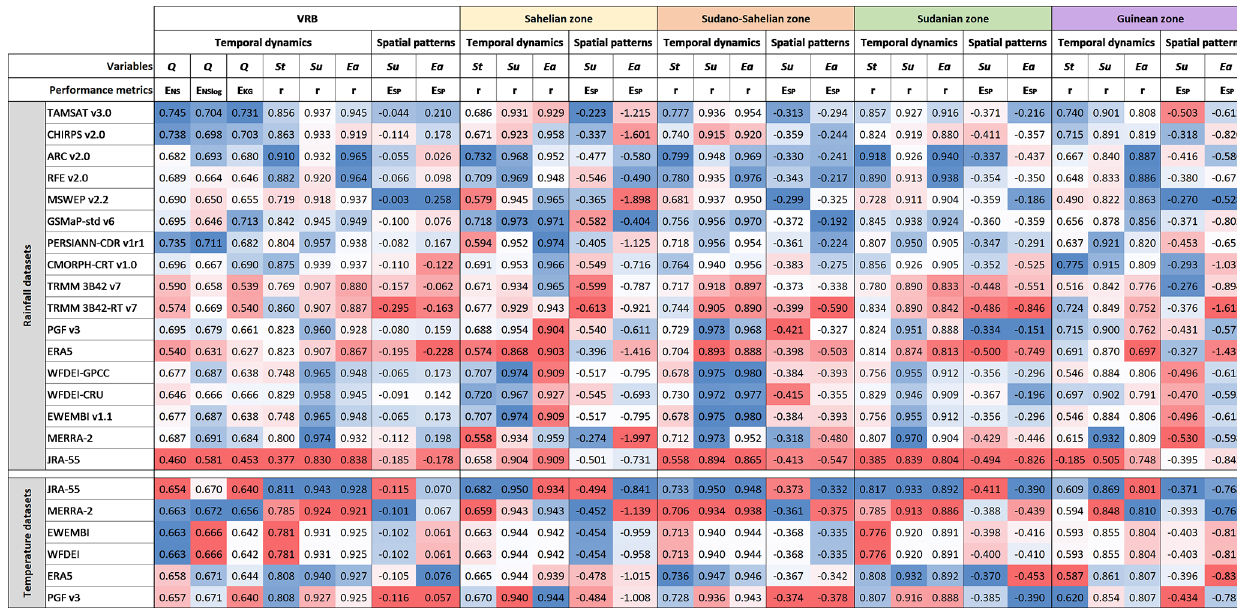
Table A1. Model performance for streamflow ( Q ), terrestrial water storage ( S t ), soil moisture ( S u ) and actual evaporation ( E a ) using various rainfall–temperature dataset combinations as model inputs. Each score for a given rainfall product represents the average over individual combinations with 6 temperature datasets, while the score is the average over combinations with 17 rainfall datasets for each temperature dataset. The skill scores of the temporal dynamics are obtained with the Kling–Gupta efficiency ( E KG ) , the Nash–Sutcliffe efficiency ( E NS ) and the Nash–Sutcliffe efficiency of the logarithm ( E NSlog ) for Q , and the Pearson’s correlation coefficient ( r ) for S t , S u and E a . The spatial pattern efficiency ( E SP ) is used to assess the spatial representation of S u and E a . The skill scores are ranked from the best (blue) to the worst (red). The results are shown for the four climatic zones in the Volta River basin (VRB) over the simulation period